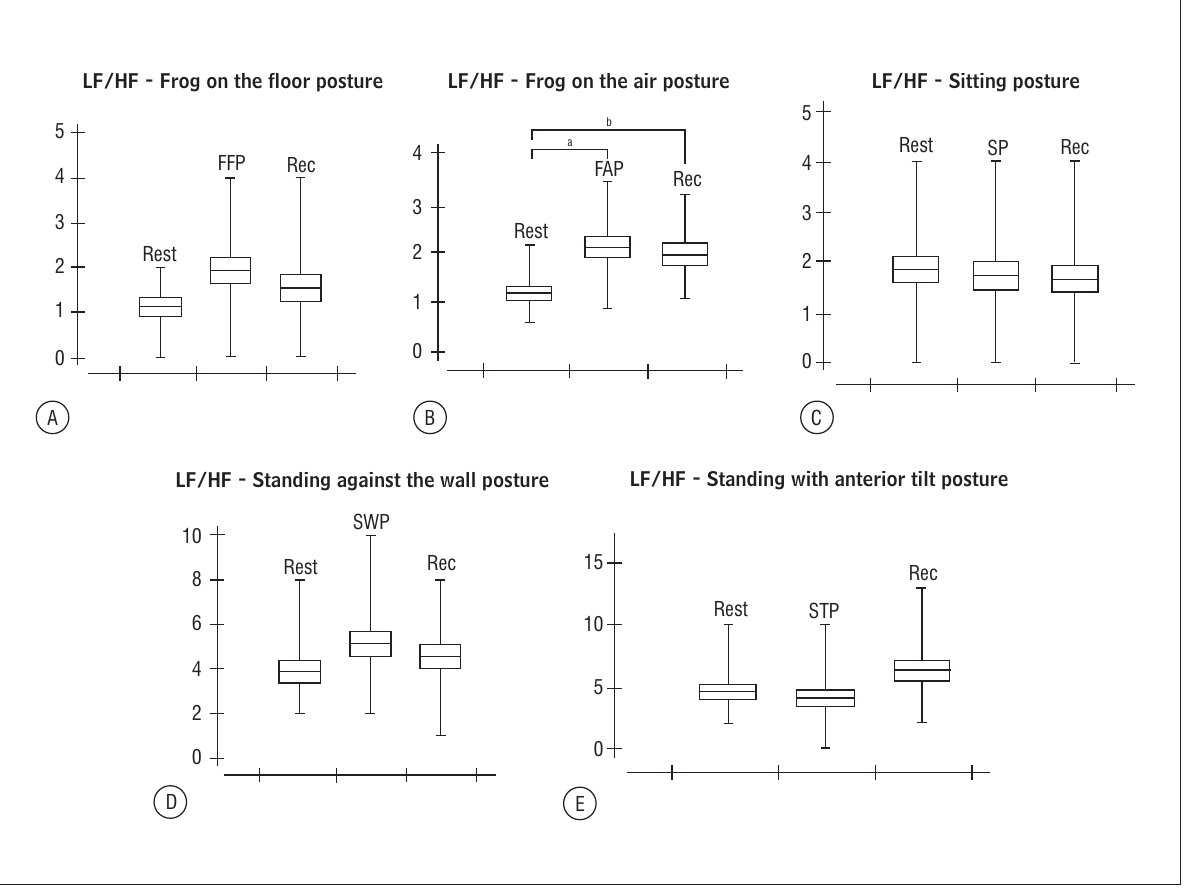
Figure 3 - Boxplot of the mean and standard error values of LH/HF ratio during the rest (Rest), during the postures: A) frog on the floor (FFP), B) frog on the air (FAP), C) sitting (SP), D) standing against the wall (SAWP), and E) standing with anterior tilt (SATP), and during the recovery